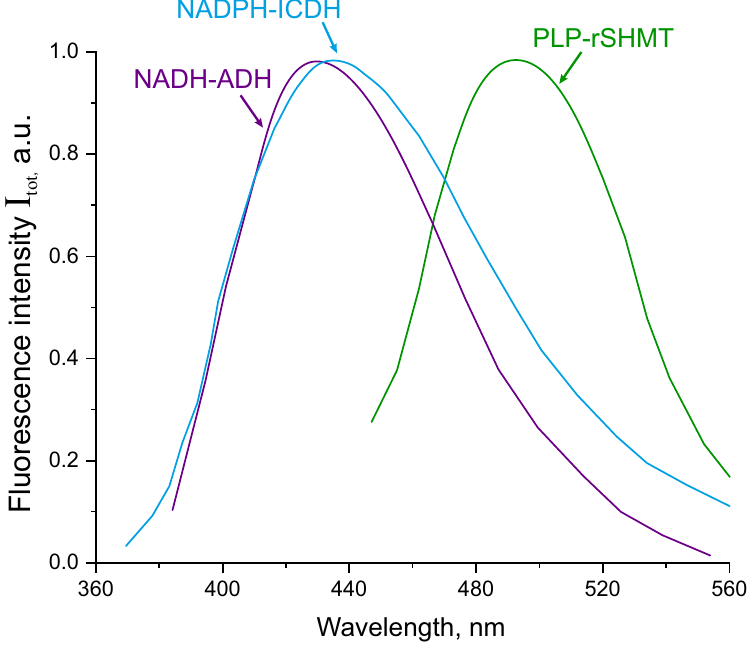
Figure 7. Fluorescence spectra of NADH-ADH [33] under excitation at 330 nm (violet curve), of PLP-rSHMT [39] (green curve), and of NADPH-ICDH (blue curve)